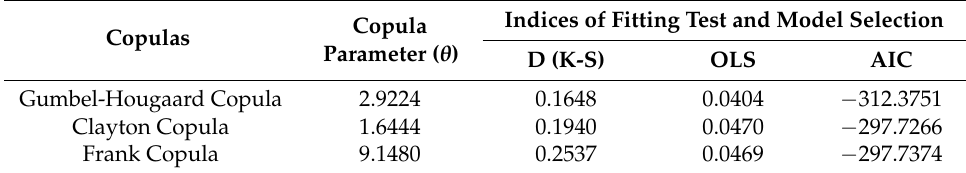
Table 3. The estimation of copula parameters and the associated fitting test and model